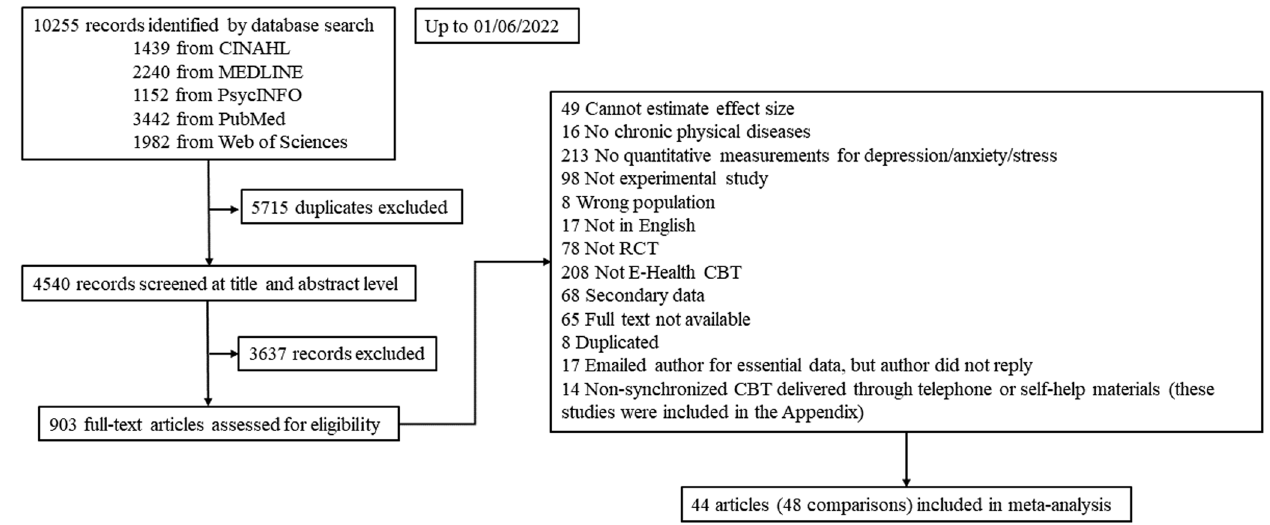
Fig. 1 PRISMA fl